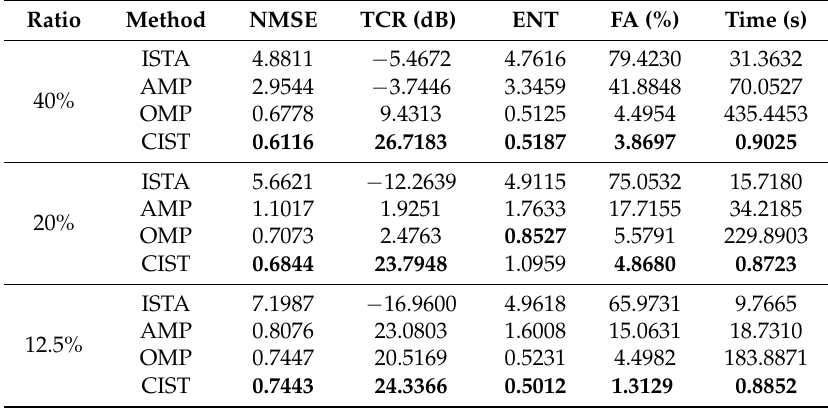
Table 2. Evaluation of Simulated Experiments (SNR = 0